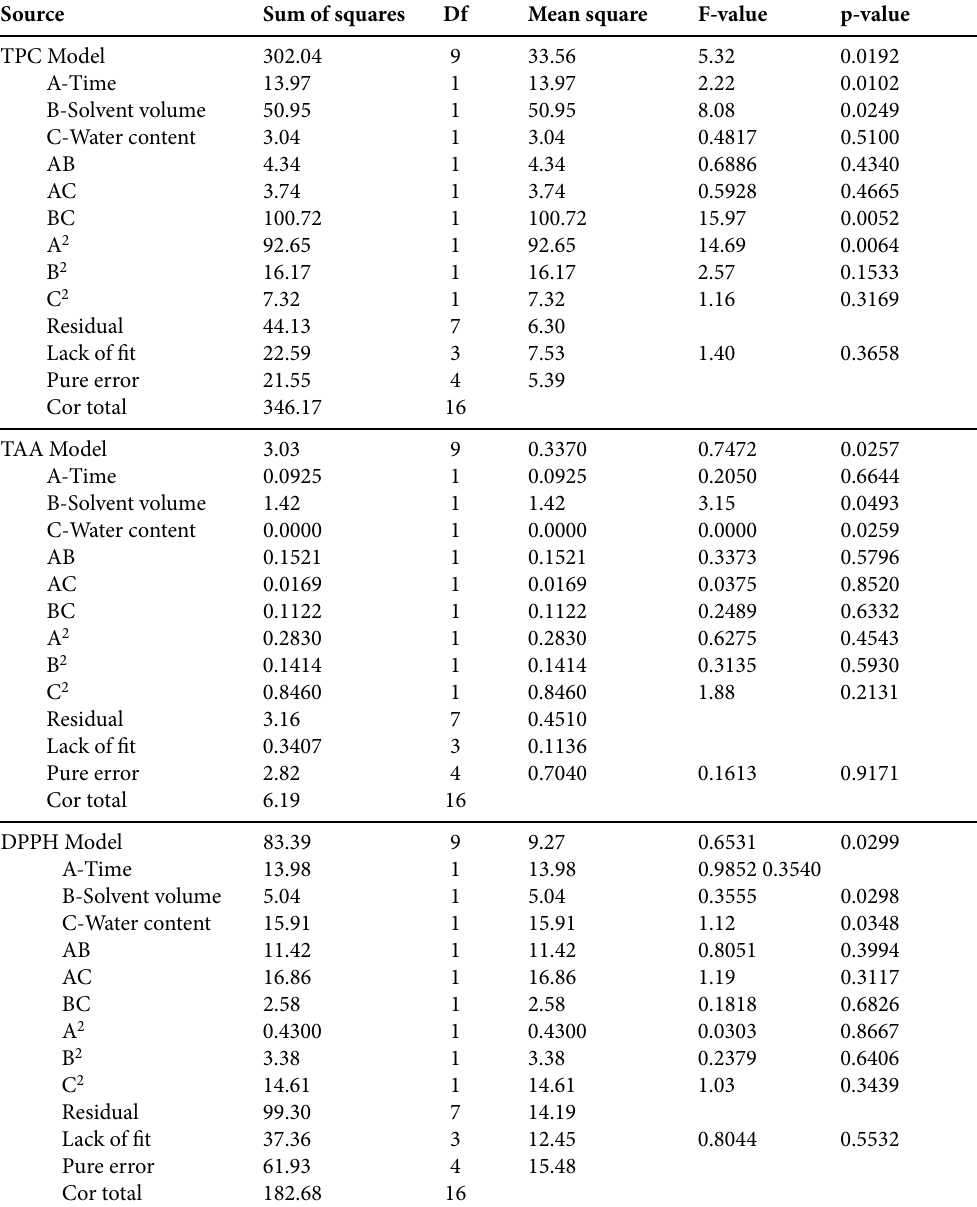
Table 5. Analysis of variance test for the Box-Behnken design for the UAE for TPC, TAA and %DPPH Source Sum of